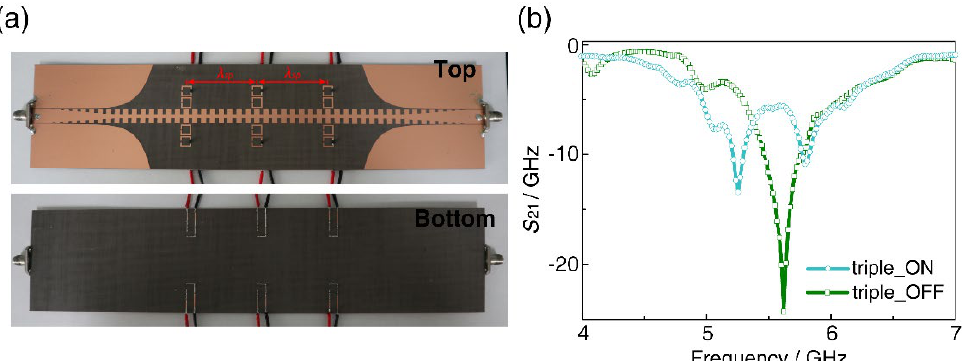
Figure 5. Experimental measurements of sample with three-cascaded EIT modules side-coupled to SSPP waveguide. ( a ) Photograph of fabricated sample in top and bottom views, and ( b ) corresponding transmission coefficients in ‘ON’ and ‘OFF’ states of PIN diodes. The word in Figure ( a ) indicates the top and bottom views, respectively.